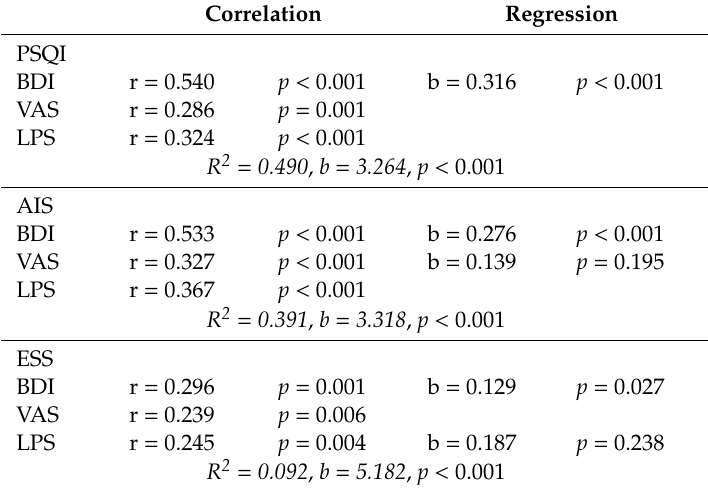
Table 4. Association between sleep questionnaires results, pain scales, and depression